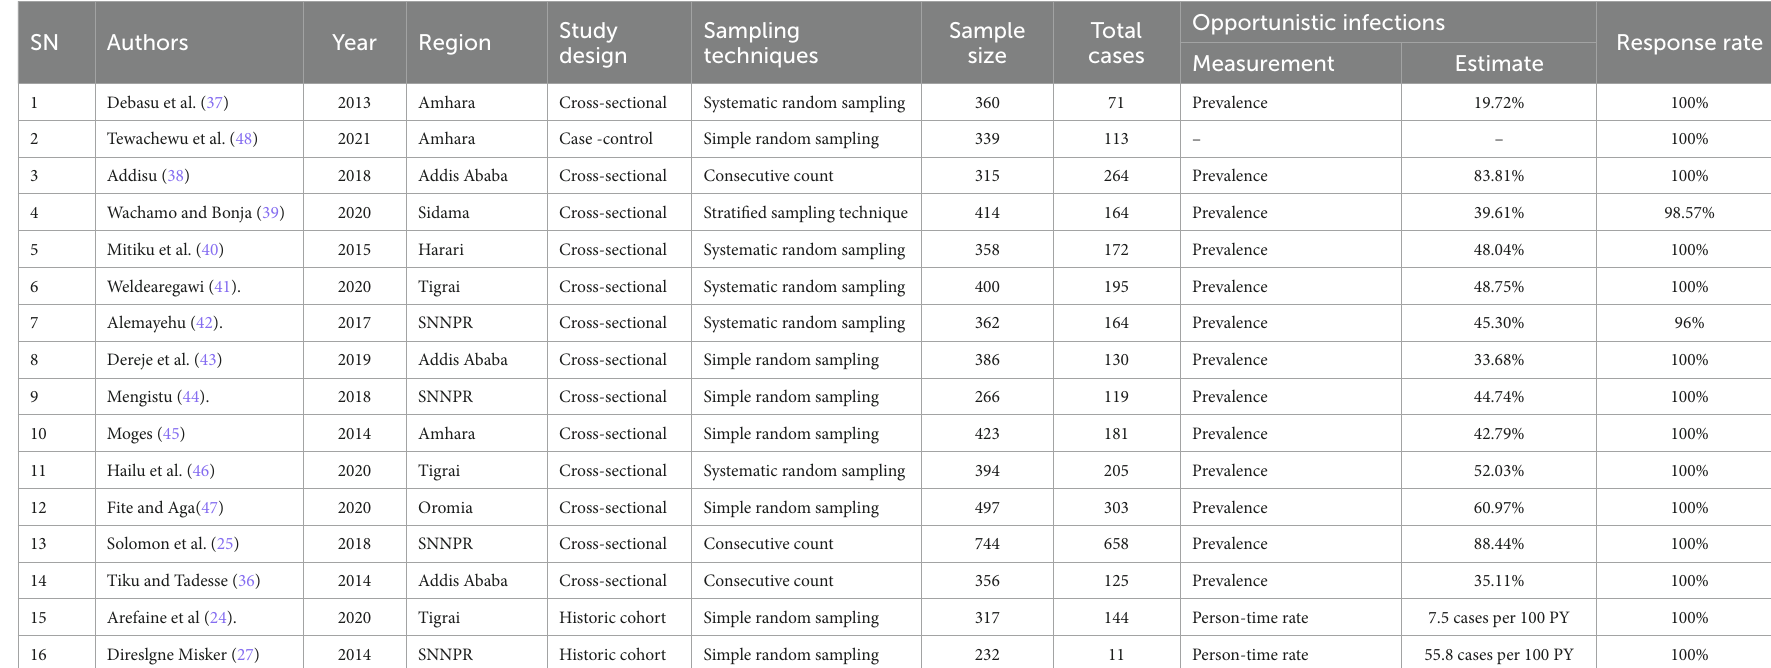
TABLE 1 The characteristics of the studies included in the systematic review and